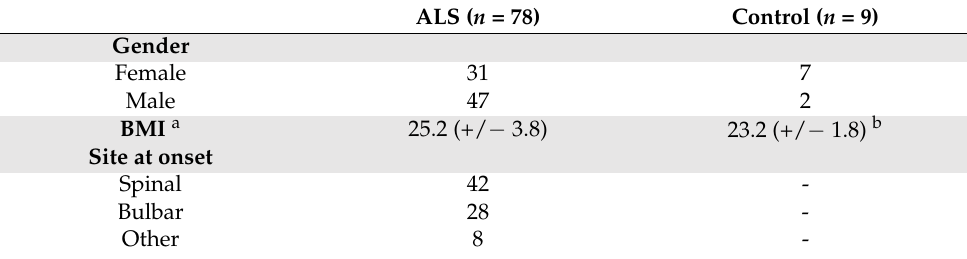
Table 1. Frozen plasma samples were analyzed by HPLC-MS/MS to detect and quantify free oxylipins. Analyzed oxylipins include LA, AA, eicosapentaenoic acid (EPA), and DHA metabolites, derived from enzymatic and non-enzymatic pathways. A full list of analyzed metabolites is shown in Table S1. Table 1. Demographic and clinical characteristics of ALS patients and control